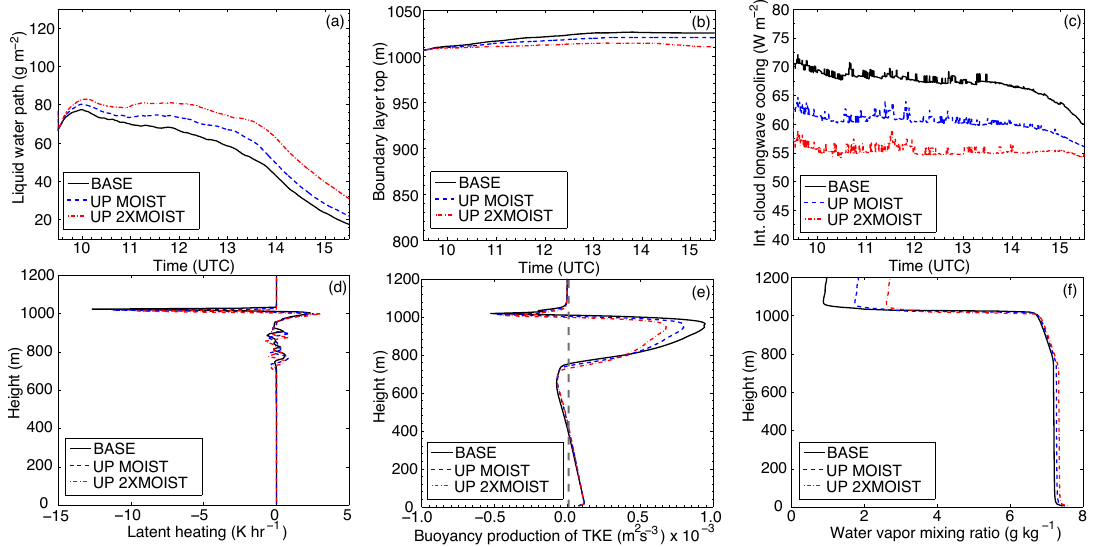
Fig. 7. LES output showing STBL response for changes in moisture jump across the cloud top interface. Time series of quantities, shown in (a) to (c) , are domain averaged and vertically integrated. Vertical profiles, shown in (d) to (f) , are domain averaged and temporally averaged over the hour of observation (12:30 to